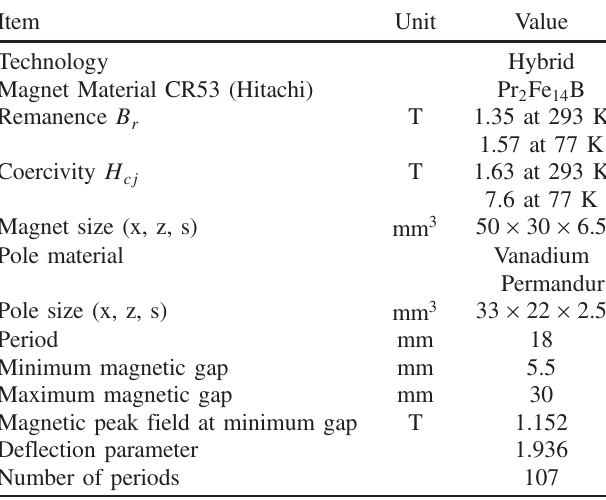
TABLE I. SOLEIL Cryogenic undulator main characteristics.